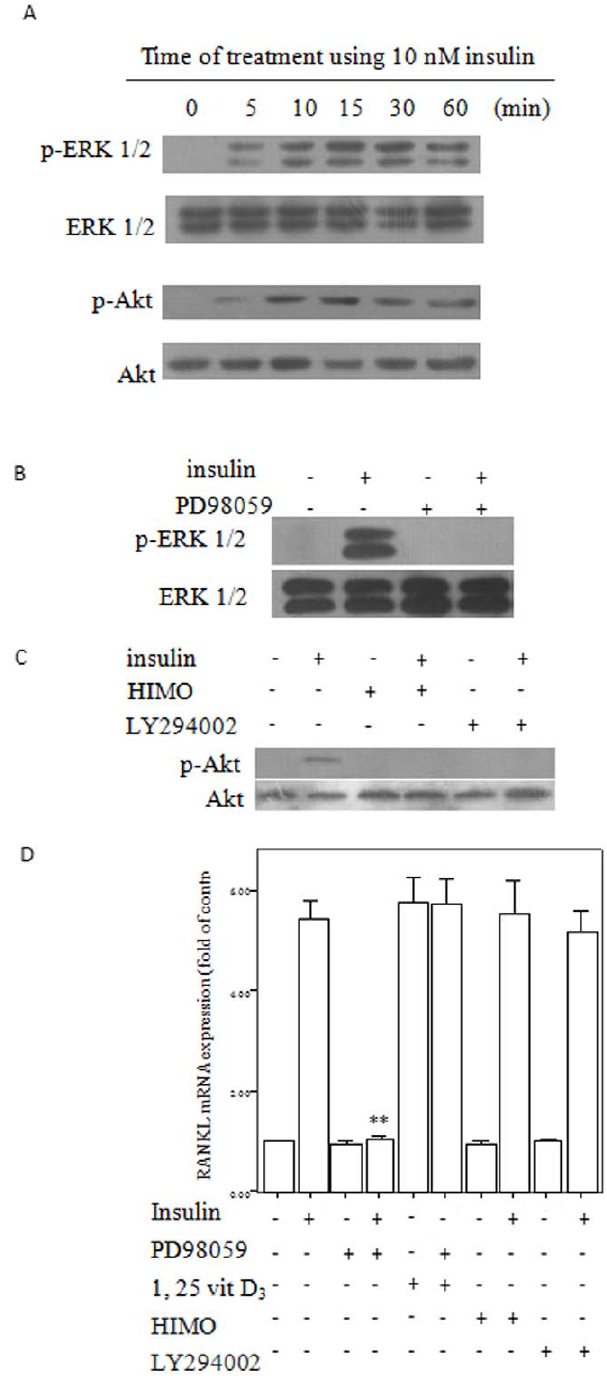
Figure 2. Insulin increased RANKL mRNA expression through ERK1/2, but not Akt signal pathway in calcifying vascular smooth muscle cells (CVSMCs). Cell lysates were subjected to western blot and incubated with anti-p-ERK1/2, ERK1/2, p-Akt, and Akt antibodies. (A) Effects of insulin on ERK1/2 and Akt activation in CVSMCs. Representative results are shown for cells exposed to 10 nM insulin for 5–60 min. (B) Cells incubated with PD98059 (10 m M) for 2 h prior to treatment with 10 nM insulin for 30 min. (C) Cells incubated with LY294002 (10 m M) or HIMO (10 m M) for 2 h prior to treatment with 10 nM insulin for 15 min. (D) Cells were incubated with PD98059 (10 m M), LY294002 (10 m M) or HIMO (10 m M) for 2 h before treatment with 10 nM insulin for 48 h. Cells were treated with 10 2 7 M 1 a